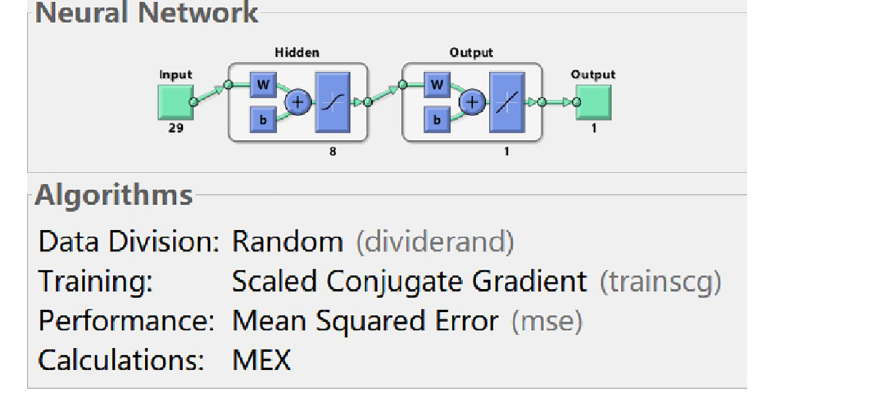
Fig 7. BP neural network structure (SCG).